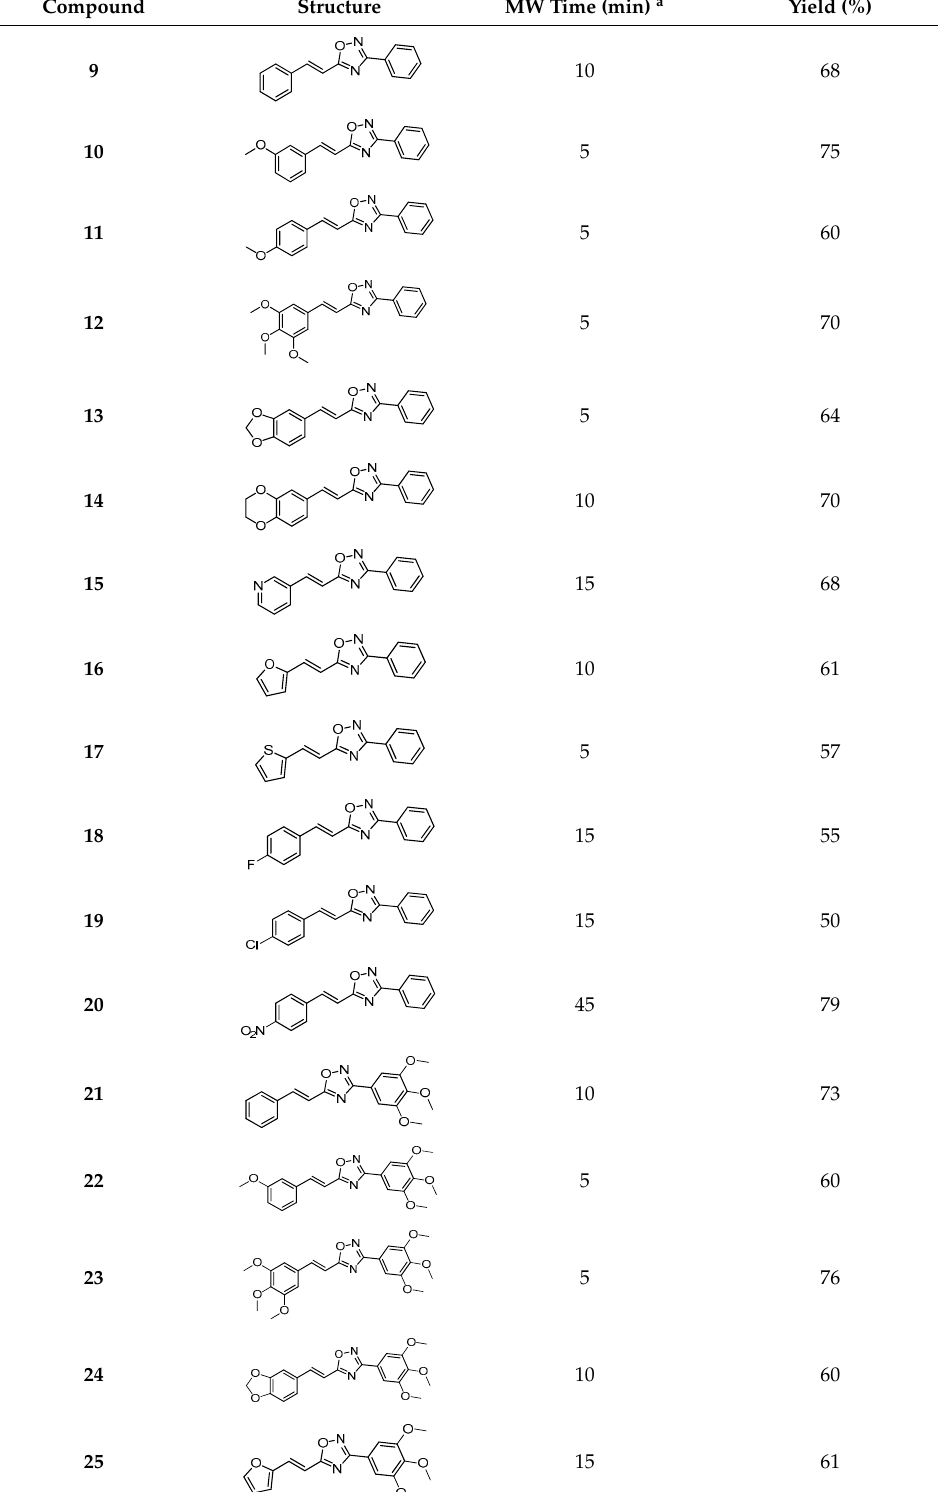
Table 1. Reaction times and yields for the synthesis of compounds 9 – 25 . Compound Structure MW Time (min) a Yield (%) Compound Structure MW Time (min) a Yield (%) 9